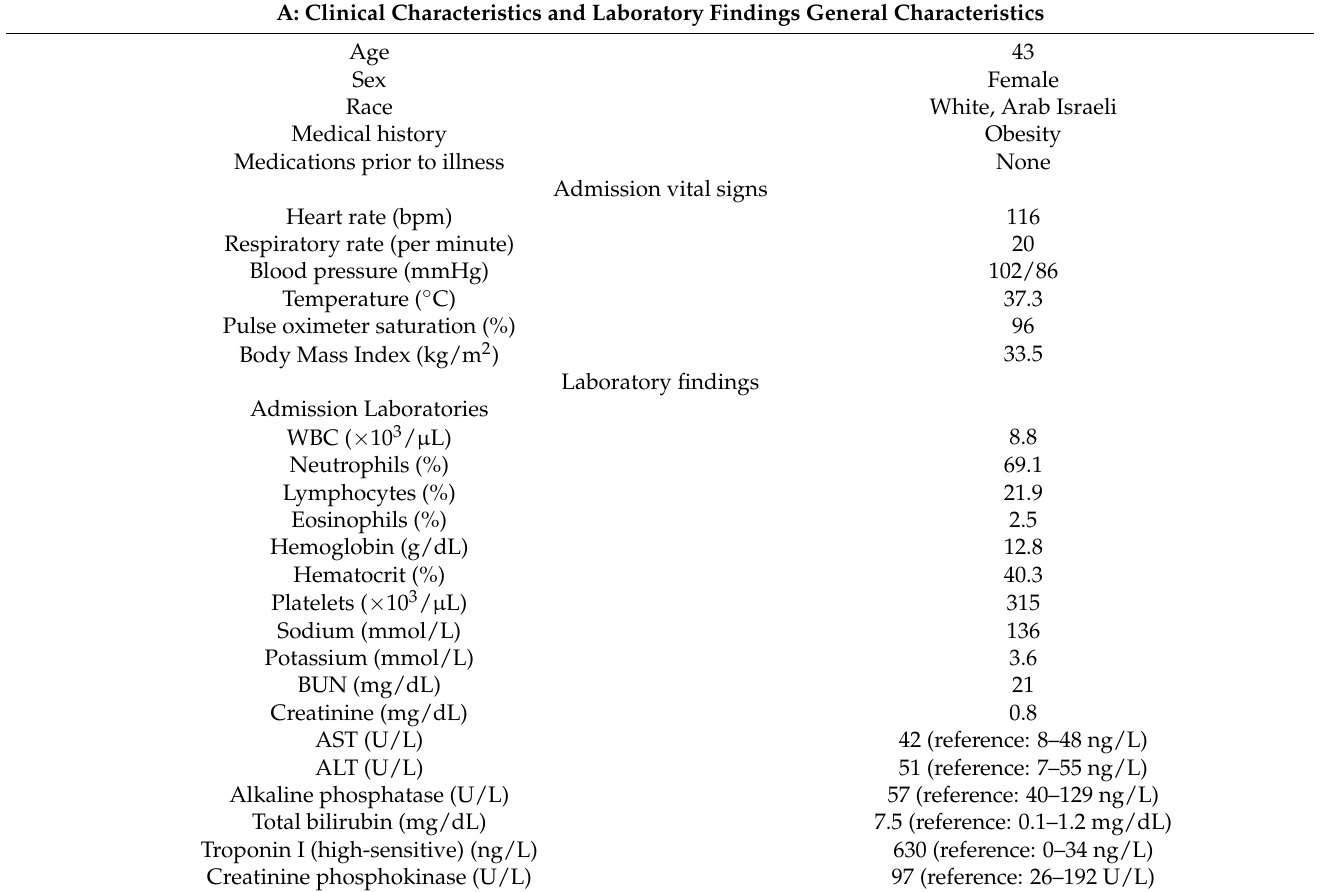
Figure 1. Electrocardiograms (EKG) on presentation. ( A ) EKG on presentation showing monomor- phic ventricular tachycardia. ( B ) EKG after cardioversion showing sinus rhythm with poor R wave progression in precordial leads without significant PR or ST segment changes. Left heart Catheteriza- tion ( C – E ) show normal coronary arteries. (Table 1B). Table 1. Patient characteristics, clinical investigations and medical